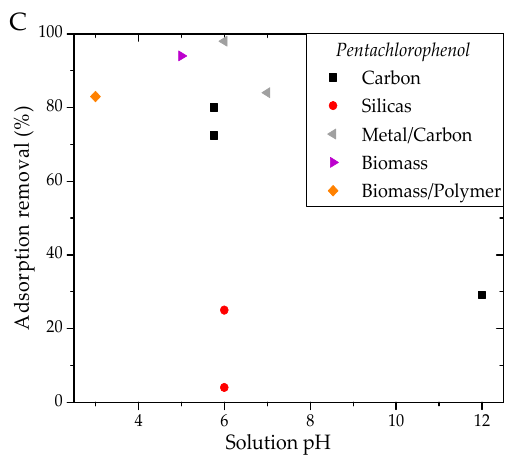
Figure Figure 7. Adsorption performance related to the adsorption test pH for several adsorbents compositions, against Phenol ( A ); 2-Chlorophenol ( B ); and Pentachlorophenol ( C ).